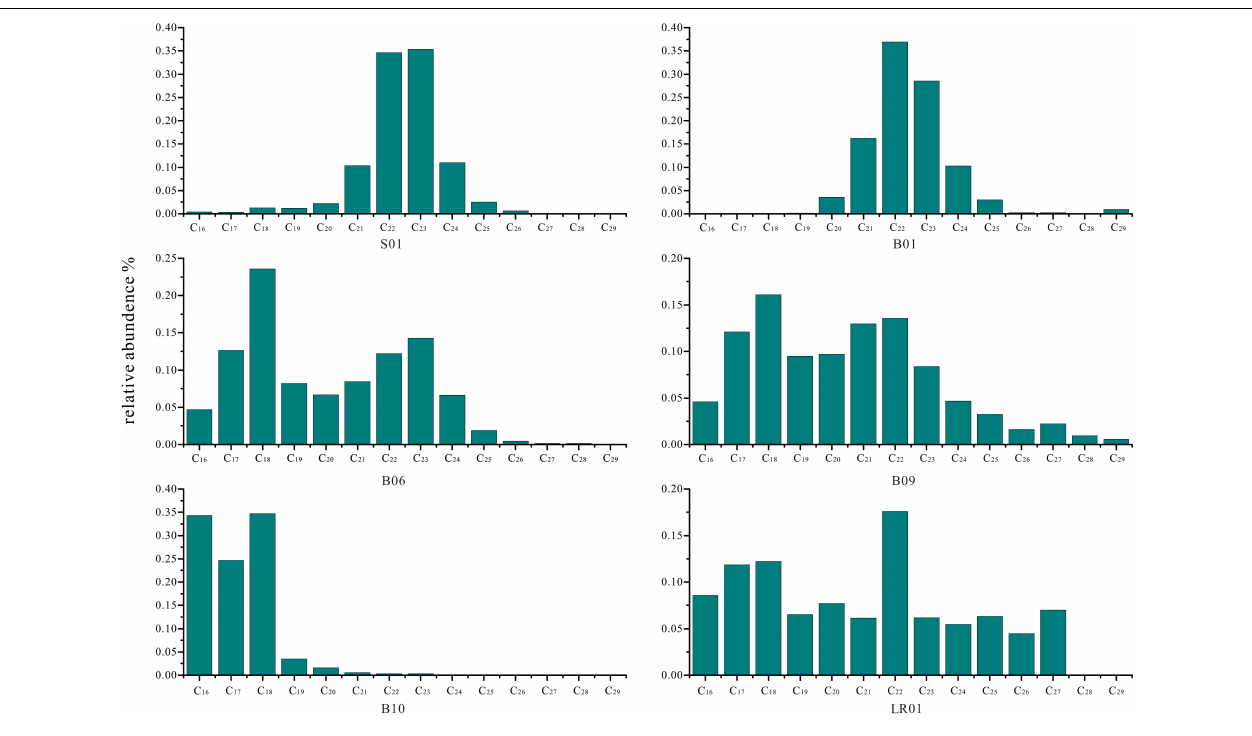
FIGURE 4 | The mean relative concentration of n -alkanes in the trench sediment